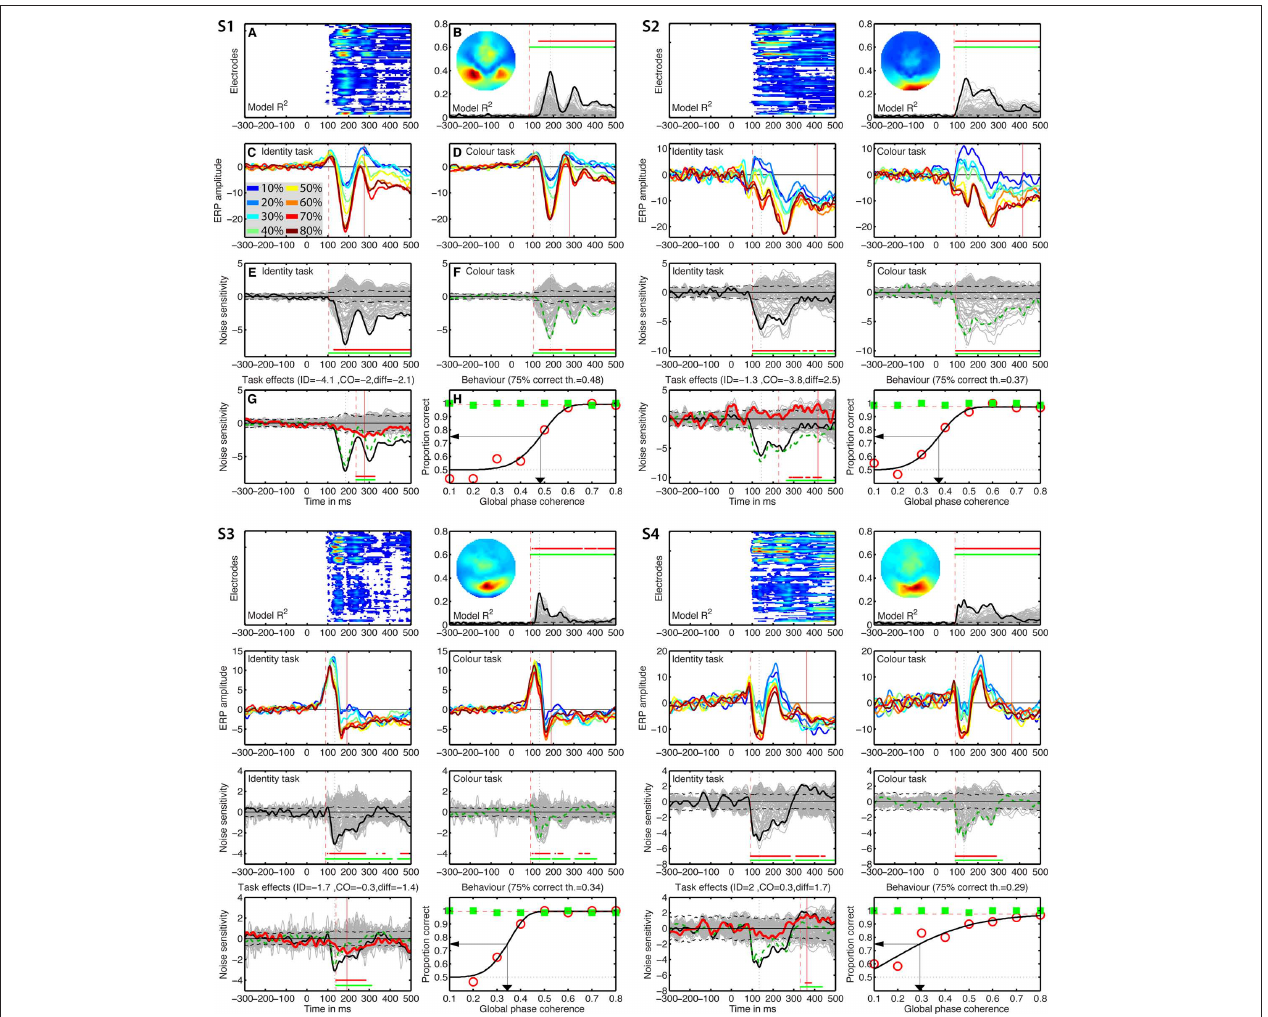
FiGuRE 5 | individual results for subjects S1 to S4. (A) Statistically significant maximum task difference and is also plotted in (D,G) . (D) Mean ERPs in the color model R 2 at all the electrodes and time frames from − 300 to 500 ms after stimulus task. The red vertical dashed line indicates the time frame of the earliest significant noise sensitivity in the color task, across all electrodes. This line is also plotted in (F) . onset. Electrodes are stacked up along the y -axis. The tick on the y -axis marks the (E) Noise sensitivity beta coefficients in the identity task. Noise sensitivity at the electrode at which the maximum R 2 was recorded. This electrode is plotted as a maximum R 2 electrode is plotted in black, the other electrodes in gray. Units are μV/ continuous black line in (B) . R 2 ranges from near zero in blue to the maximum for that subject in red. (B) Model R 2 at all the electrodes and time frames. The electrode std of the predictor. Near the bottom of the panel, the upper horizontal line (red) marks significant noise sensitivity time frames at the maximum R 2 electrode. The at which the maximum R 2 was recorded is plotted in black. The other electrodes are plotted in gray. The inset shows the topographic distribution of the R 2 at the latency lower horizontal line (green) marks significant noise sensitivity time frames of the spatial–temporal cluster to which the maximum R 2 electrode belonged. The black of the maximum, indicated by a vertical black dotted line. This vertical line is also plotted in all the other panels for comparisons. For subject S horizontal dashed lines show the univariate two-sided 95% confidence interval of , R 2 had a bilateral 1 noise sensitivity under H0, at the maximum R 2 electrode. (F) Noise sensitivity beta occipital–lateral distribution, with a maximum over the left hemisphere (left bottom red cluster). The red vertical dashed line indicates the time frame of the earliest coefficients in the color task. Noise sensitivity at the maximum R 2 electrode is significant R 2 across all electrodes. Near the top of the panel, the upper horizontal plotted as a green dashed line, the other electrodes in gray. (G) Noise sensitivity beta coefficient task differences. Noise sensitivity differences at the maximum R 2 line (red) marks significant time frames at the maximum R 2 electrode. The lower horizontal line (green) marks significant time frames of the spatial–temporal cluster electrode are plotted as a thick red line, the other electrodes in gray. The black to which the maximum R 2 electrode belonged. For subject S continuous line and the green dashed line are the same as those in (E,F) . The red , this horizontal line 1 continuous vertical line indicates the latency of the maximum task difference. At that starts at the latency of the earliest significant model fit (red vertical dashed line), latency, the title indicates the amplitude of the noise sensitivity in the identity task indicating that the maximum R 2 electrode is part of a spatial–temporal cluster that (ID), in the color task (CO), and the difference between the two tasks (diff). (H) captures the earliest effects. The horizontal dashed line is the univariate one-sided Proportion correct as a function of global phase coherence, in red circles for the 95% CI of the R 2 under H0, at the maximum R 2 electrode. Although this is for identity task, in green squares for the color task. Data from the identity task were illustration only, because the actual statistical test was based on spatial–temporal fitted with a cumulative Weibull function. The vertical arrow points to the 75% clusters, it gives a good indication of the R 2 values expected by chance. (C) Mean correct threshold in the identity task. The threshold appears in bracket in the title. The ERPs in the identity task. The red vertical dashed line indicates the time frame of the red horizontal dashed line marks the maximum proportion correct in the identity task earliest significant noise sensitivity in the identity task, across all electrodes. This line obtained from is also plotted in (E) . The red continuous vertical line indicates the latency of the